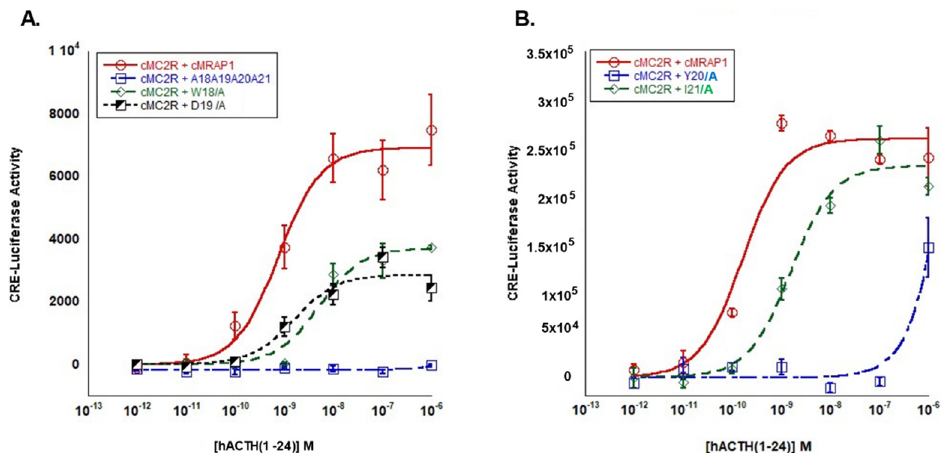
Figure 2. Analysis of W 18 D 19 Y 20 I 21 motif in chicken MRAP1. ( A ) Activation of chicken (c) MC2R co-transfected with either wildtype cMRAP1 (positive control) or alanine substitution mutants of cMRAP1 : cMRAP1 − A 18 A 19 A 20 A 21 , cMRAP1 − W 18 /A , or cMRAP1 − D 19 /A . ( B ) Activation of cMC2R co-transfected with either wildtype cMRAP1 (positive control) or alanine substitution mutants of cMRAP1 : cMRAP1 − Y 20 /A or cMRAP1 − I 21 /A . Receptor activation was assessed after stimulation with hACTH(1-24). Data presented as mean ± SEM ( n =